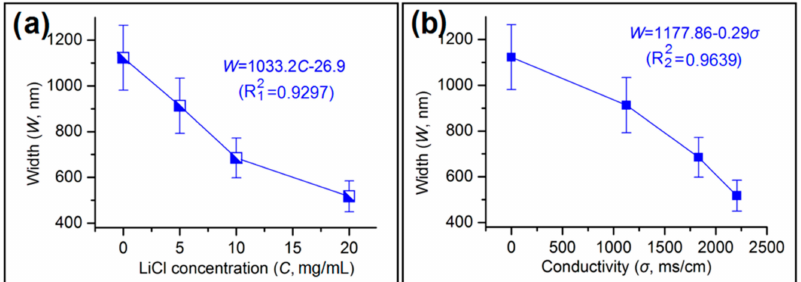
Figure 7. Correlations between the width of electrospun zein nanoribbons with: ( a ) The LiCl concentration; and ( b ) the conductivity of the sheath fluid.